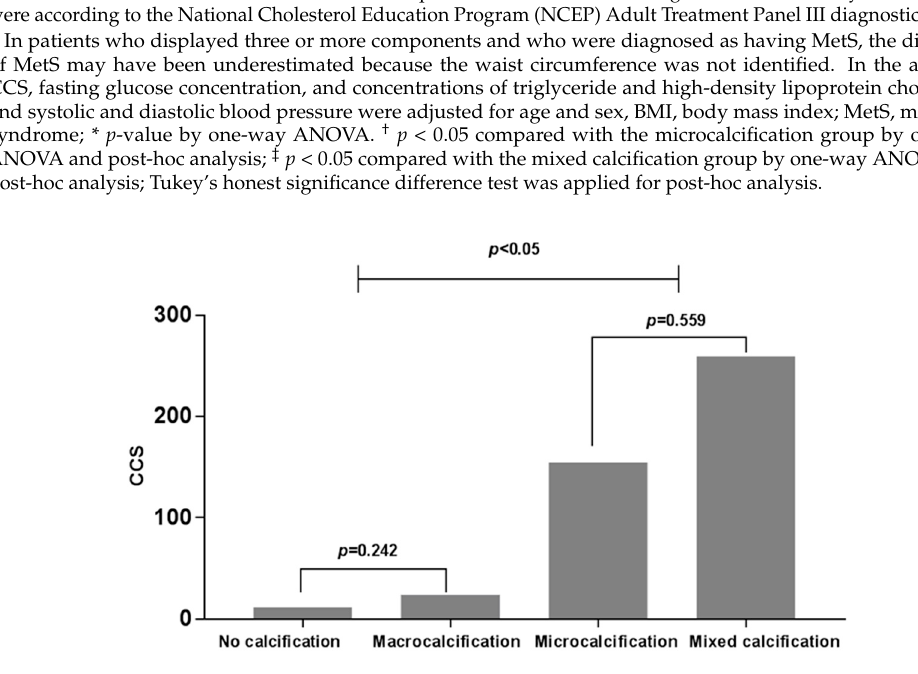
Figure 2. Coronary calcium score (CCS) according to PTC calcification pattern measured in 112 of 182 subjects. p -value by one-way ANOVA.